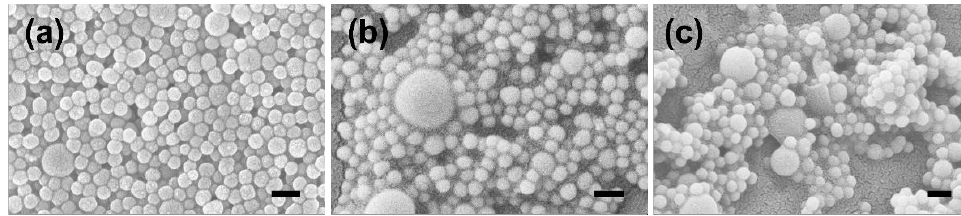
Figure 1. SEM images of PMO-PFC ( a ), Ru(PMO-PFC) ( b ), and Ru(PMO-PFC)PDL ( c ). Scale bars equal 300 nm. equal 300